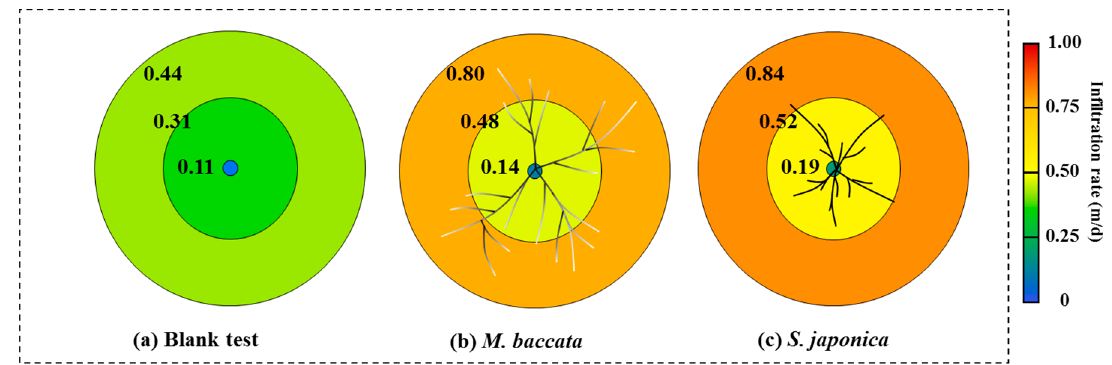
Figure 7. Mean soil infiltration rates at different distances from the tree trunks in the three test tanks: ( a ) blank test, ( b ) M. baccata , and ( c ) S. japonica . ( a ) blank test, ( b ) M. baccata , and ( c ) S. japonica